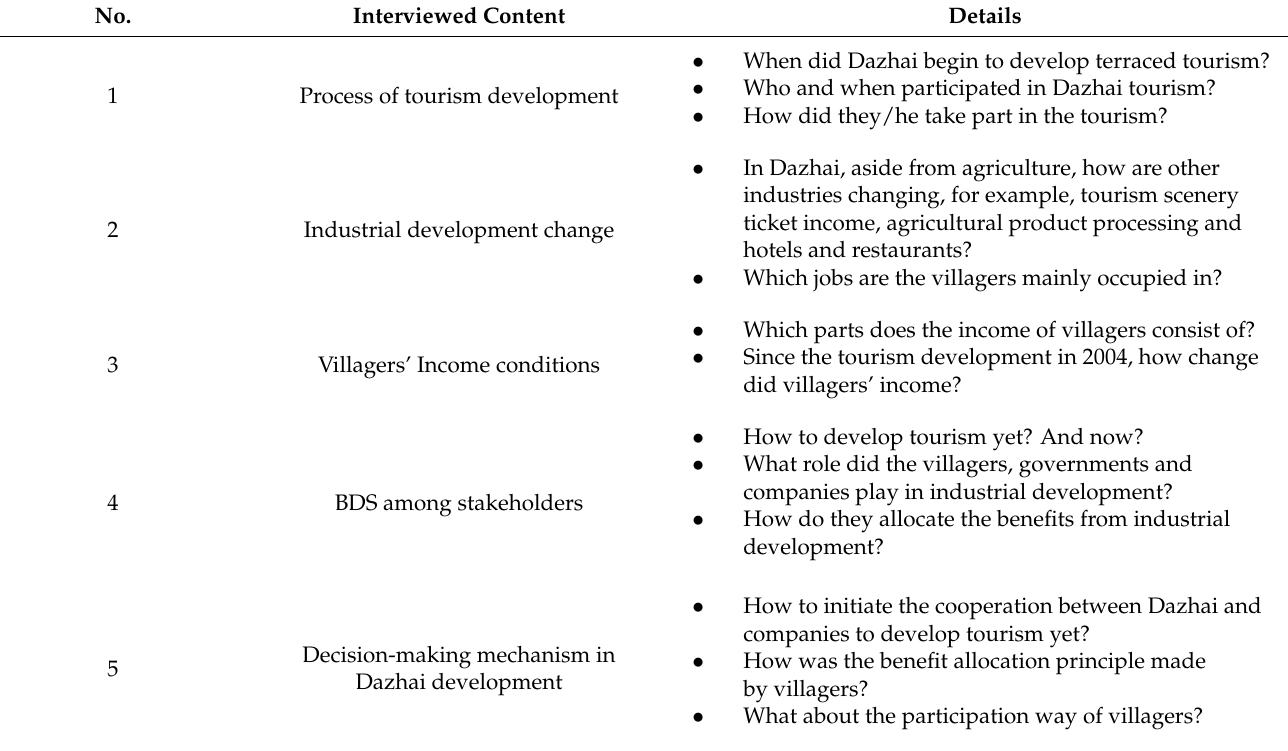
Table 1. Outline of the semi-structured interview for village officials and